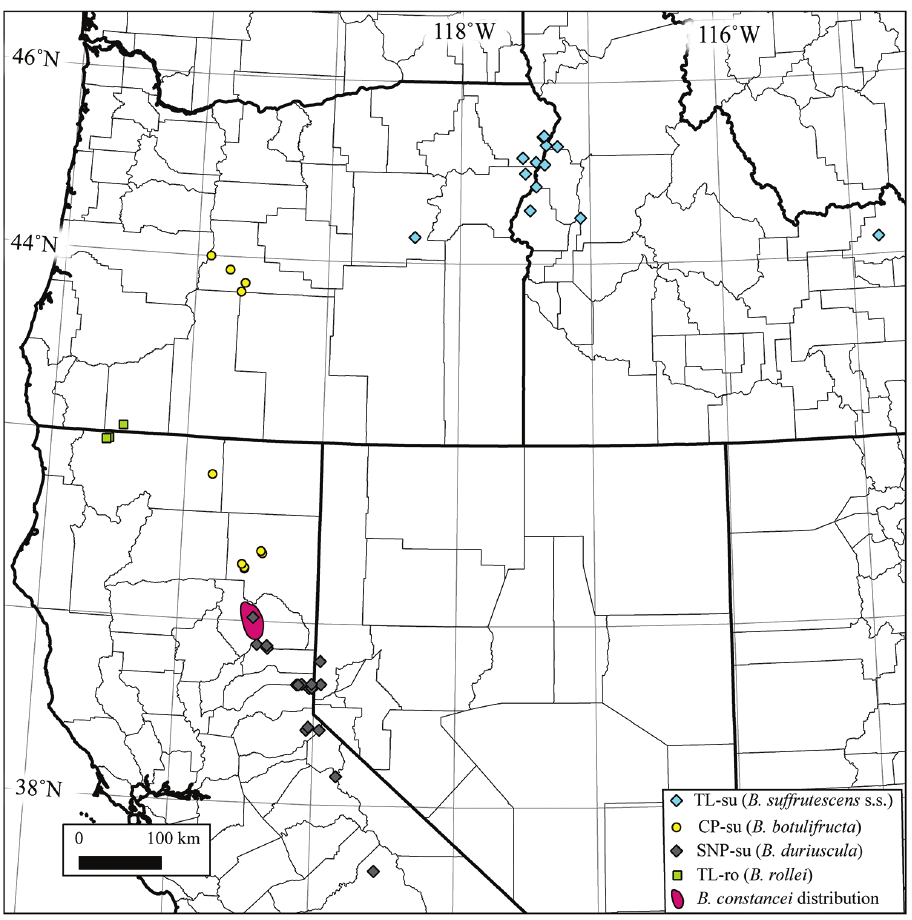
Figure 3. Geographic distribution of B. suffrutescens (CP-su, SNP-su, and TL-su) and B. rollei (TL-ro) lineages inferred from Analysis 2. A map of Plumas Co., California with distributions of the B. constancei clusters is presented in Fig.